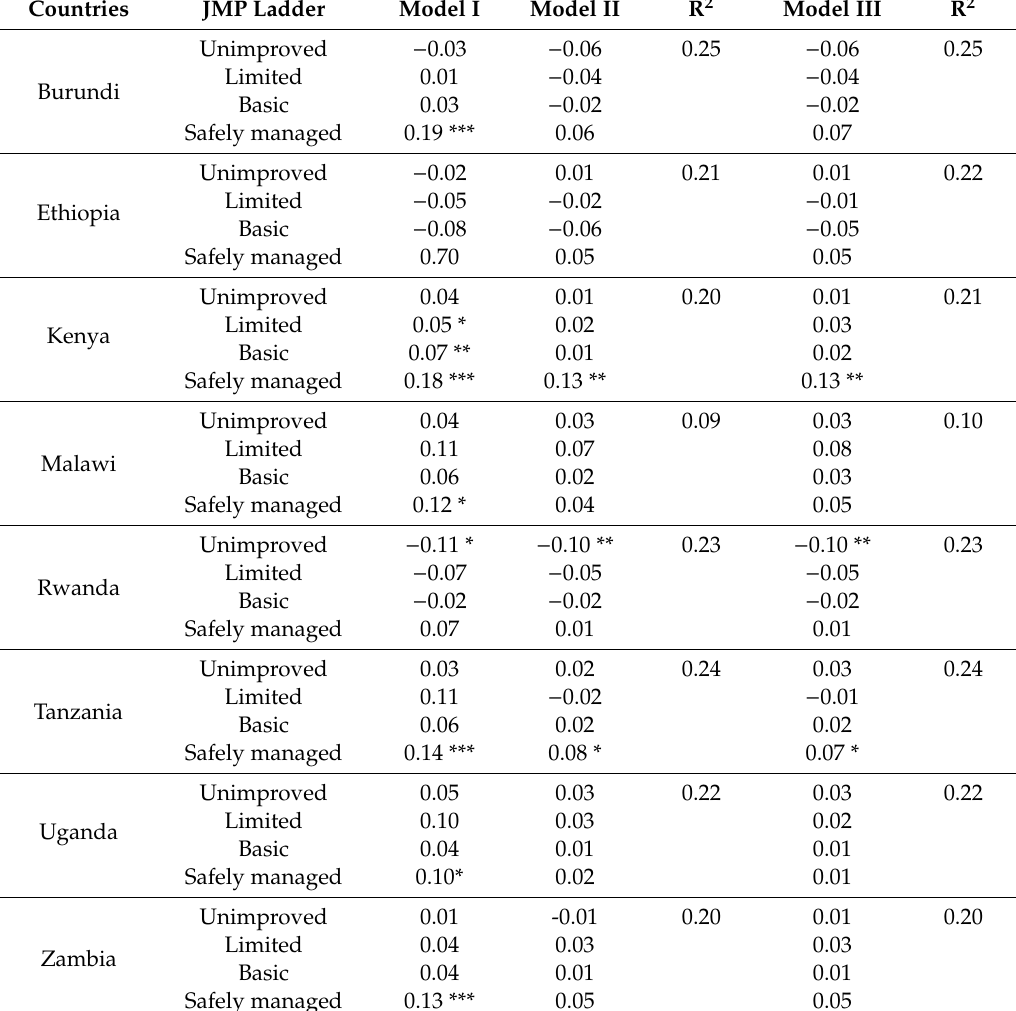
Table 4. Predicted increments in young child length-for-age z-scores (LAZ) (6–23 mo) associated with JMP water supply indicators in East Africa.